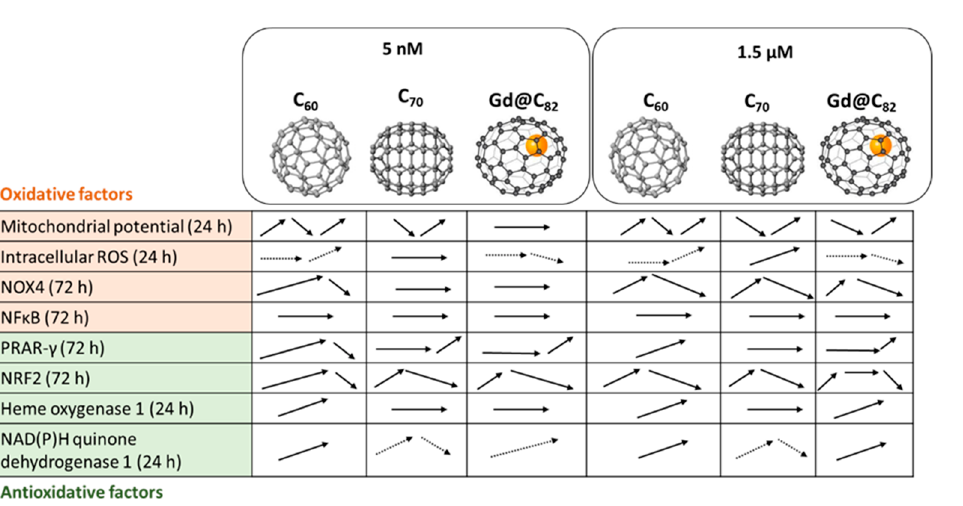
Figure 13. The dynamics of changes in the studied parameters over time (the time range is indicated in the first column) for two concentrations of aqueous fullerene dispersions. Solid lines denote significant changes and dashed lines, trends.